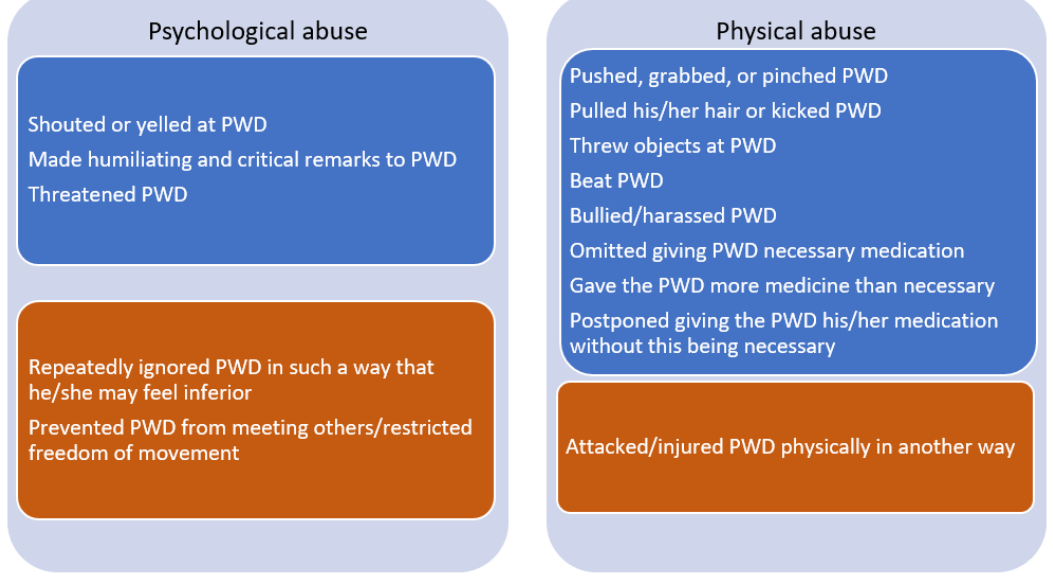
Figure 3. Items measuring abusive episodes. Blue adapted from Botngård et al. [29], orange adapted from Sandmoe et al. [30]. PWD: person with dementia.